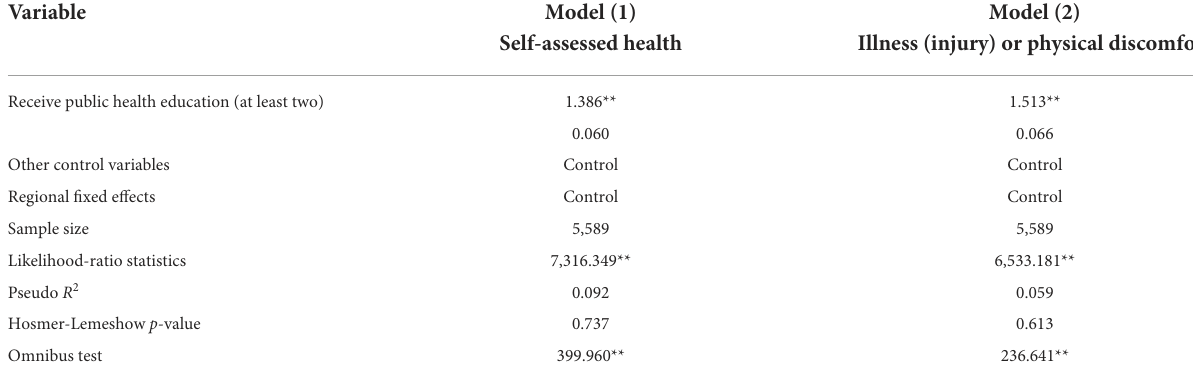
TABLE 3 Robustness test